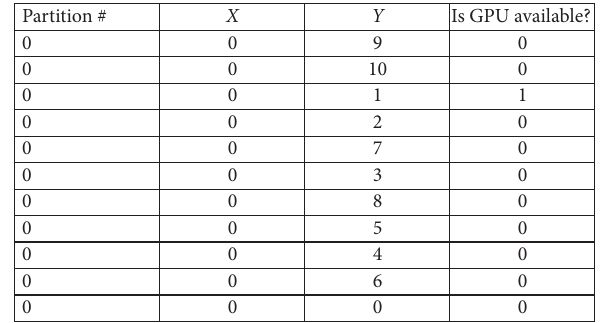
Figure 7: Example of virtual topology data